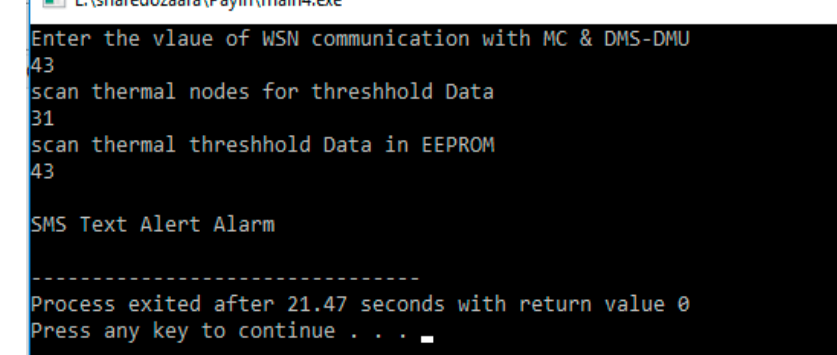
Figure 8. Critical alert maximum temperature above 30 °C.